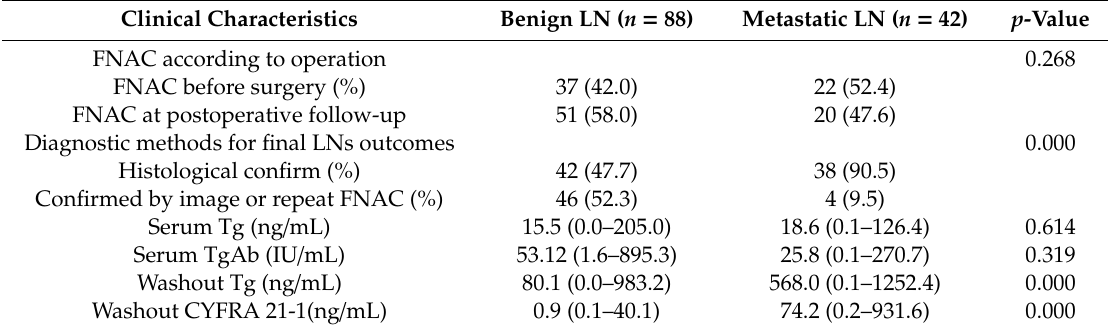
Figure 1. Distribution of washout thyroglobulin (Tg) and washout Cytokeratin fragment 21-1 (CYFRA 21-1) values in benign and metastatic lymph nodes (LNs) on fine-needle aspiration ( a ) Metastatic LNs had a significantly higher median washout Tg than that of benign LNs ( p = 0.000, by Mann–Whitney U test). The median washout of metastatic LNs and benign LNs was 568.0 and 80.1 ng / mL. ( b ) Metastatic LNs had a significantly higher median washout CYFRA 21-1 than that of benign LNs ( p = 0.000, by Mann–Whitney U test). The median CYFRA 21-1 of metastatic LNs and benign LNs was 74.2 and 0.9 ng / mL. Table 1. Clinical characteristics of 130 lymph nodes evaluated in the